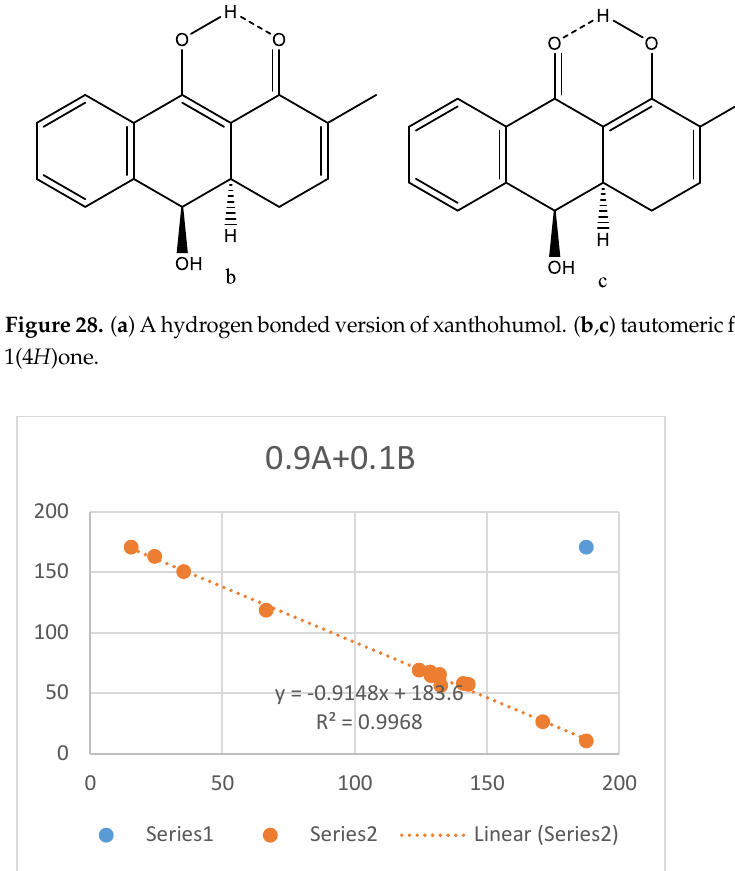
Figure 29. Plot of experimental 13 C chemical shifts vs. 13 C calculated nuclear shieldings, B3LYP, 6-31G(d).